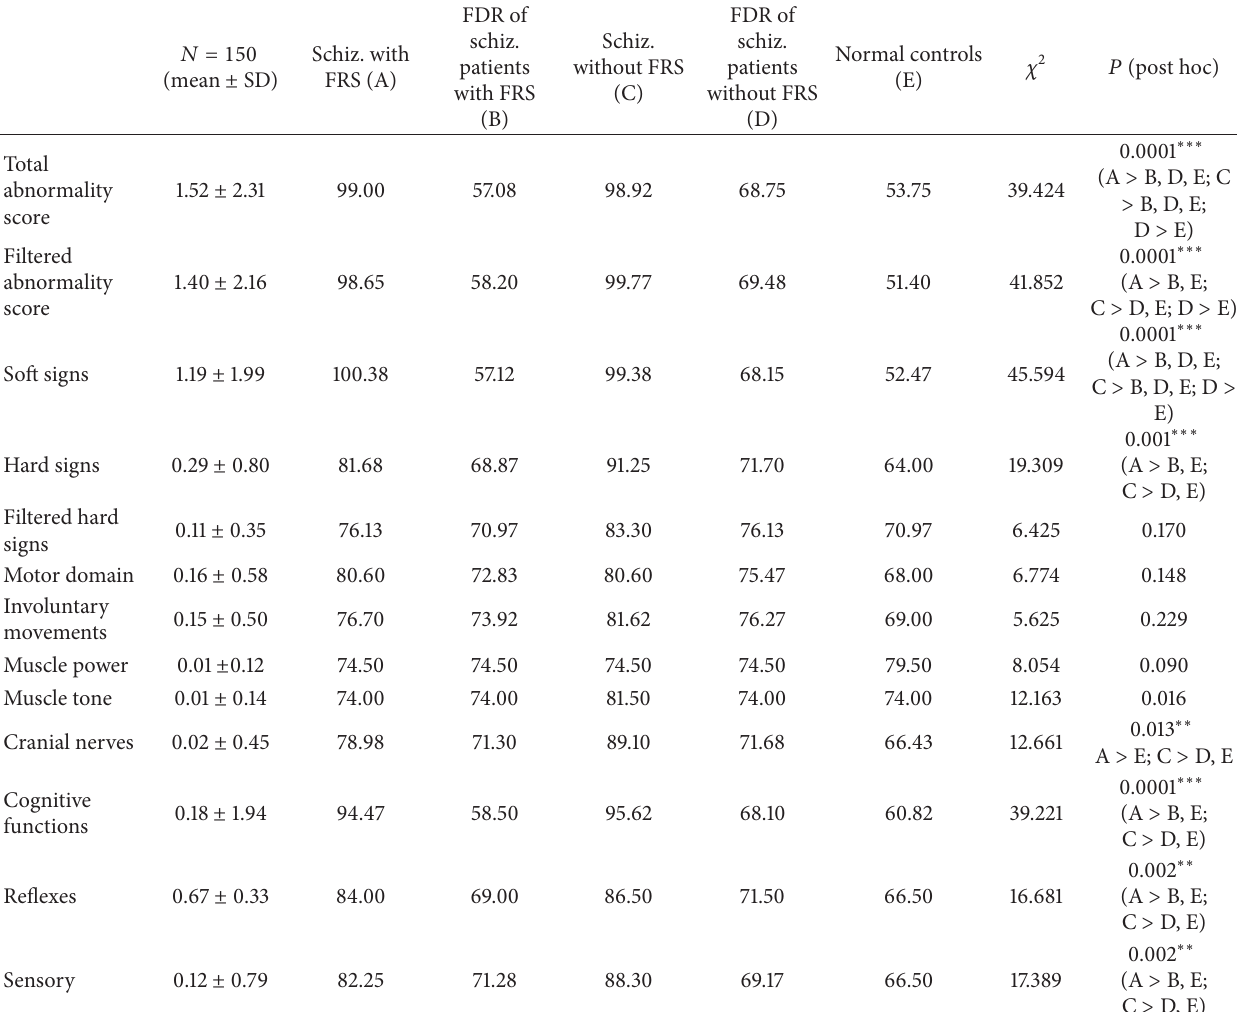
Table 4: Comparison of neurological soft sign (NSS) scores between patients of schizophrenia with and without first rank symptoms using Kruskal-Wallis